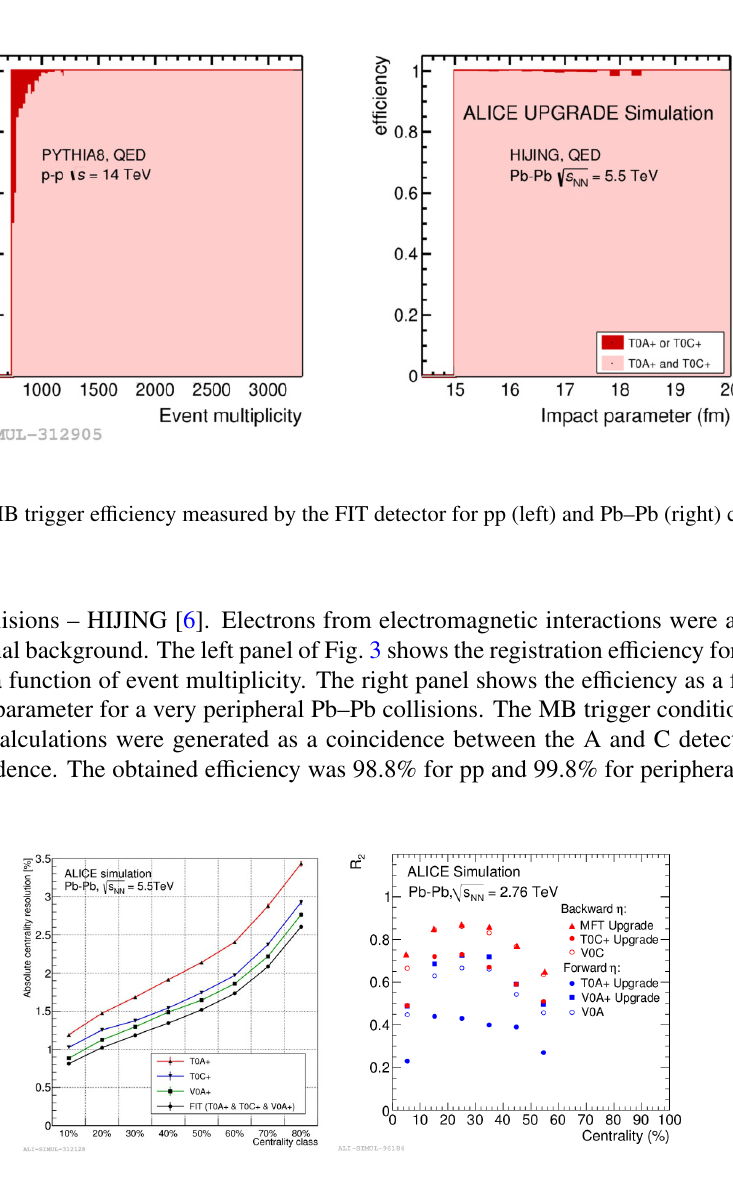
√ s NN = 5 . 5 TeV. Right: